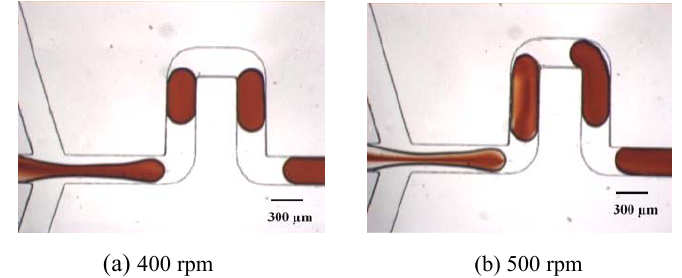
5 Flow images of mixing between ferric chloride and a within the droplets at Ω = 400 and 500